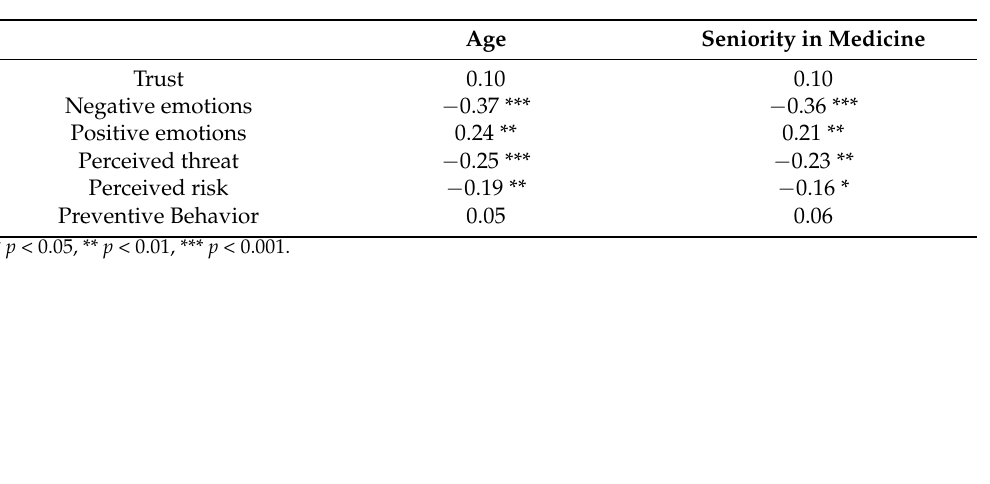
Table A1. Pearson correlations between the study variables and age and seniority in medicine ( N =